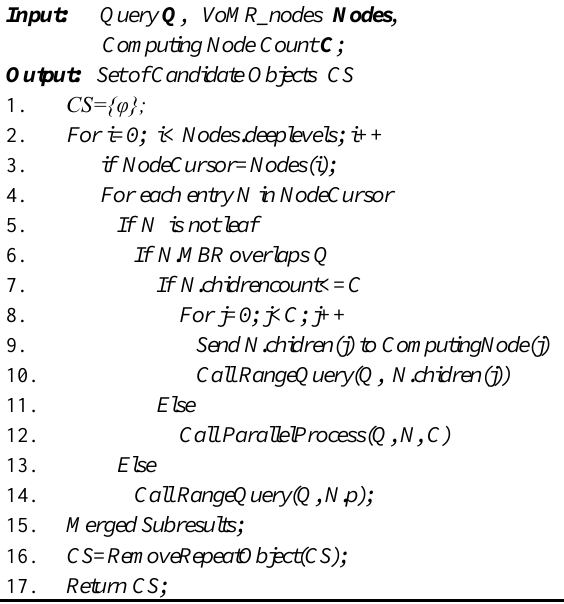
Algorithm 2 . ParallelProcess(Q, Nodes, C)